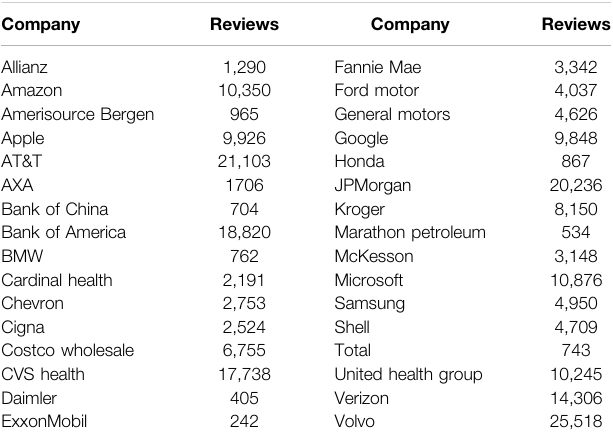
TABLE 1 | Number of reviews per